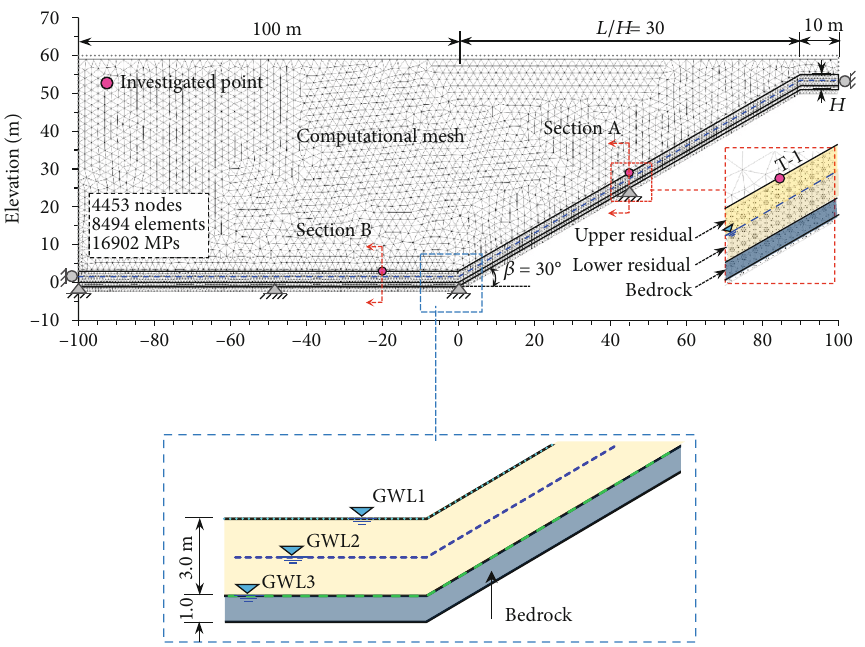
Figure 6: Initial geometry of the numerical model for the baseline case and parametric study (enlarged part shows three groundwater level using in the parametric